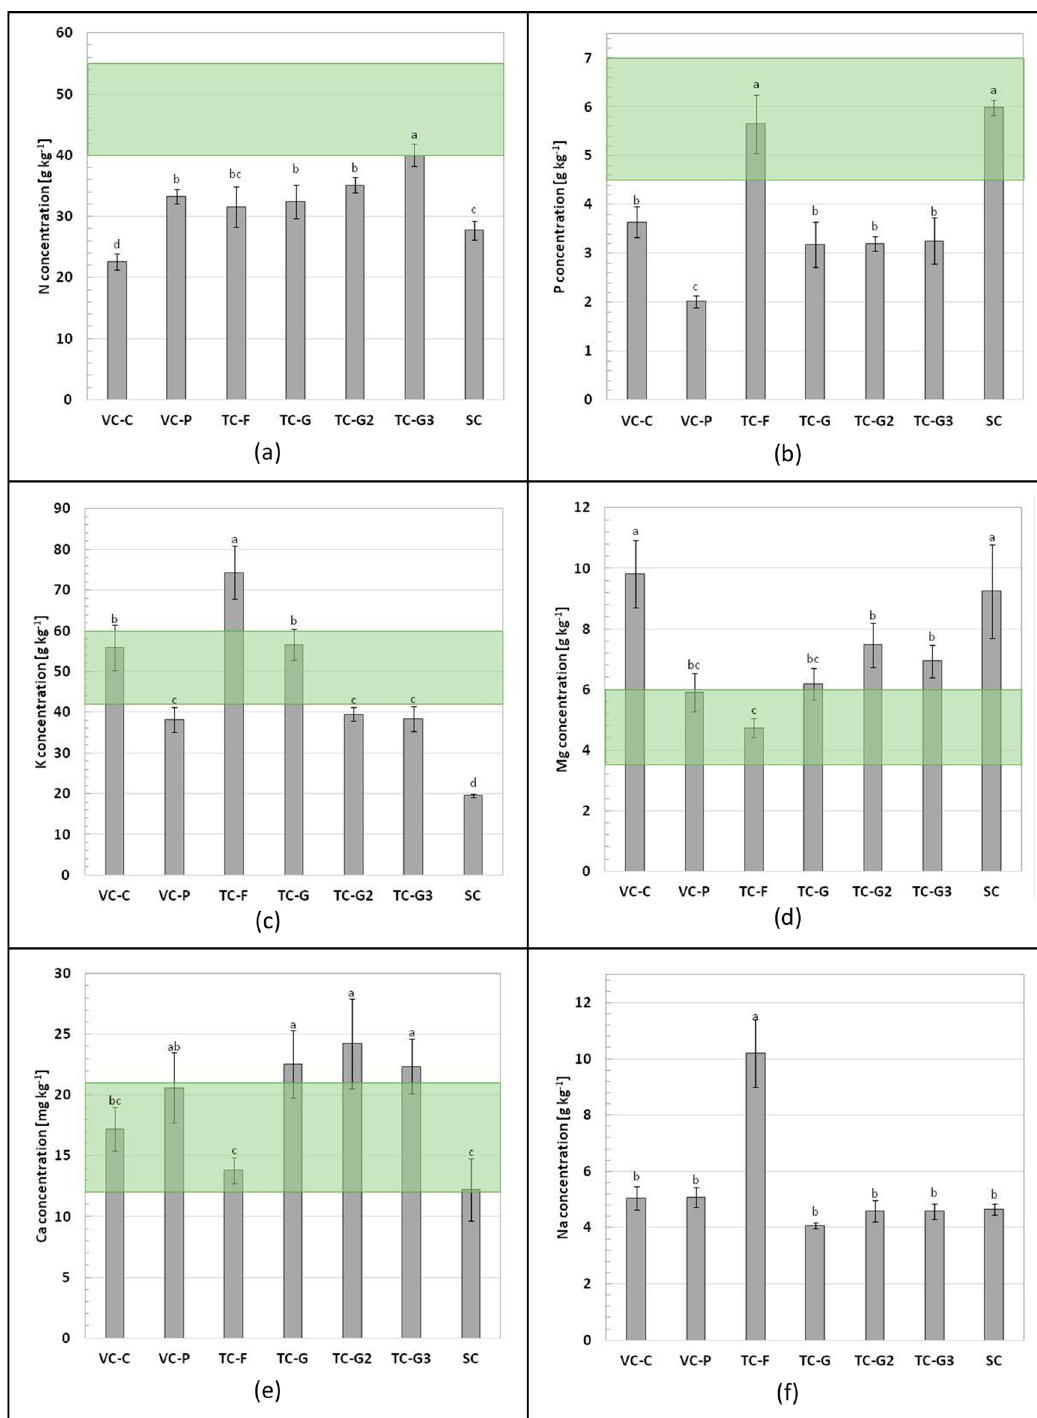
Figure 2. Contents of nutrient ( a ) N, ( b ) P, ( c ) K, ( d ) Mg, ( e ) Ca and ( f ) Na in lettuce shoots grown in all tested treatments ( n = 5). Error bars indicate standard deviation. Different letters reflect that means significantly differ from one another (HSD, Tukey test, α = 0.05; n = 5). The area highlighted in green represents the optimum range of contents, according to Bergmann [40]. SC, sand control; TC-F, thermophilic compost from fecal matter; TC-G, thermophilic compost from green waste; TC-G2 and TC-G3, thermophilic compost from green waste with additional N fertilization; VC-C, vermicompost with coir bedding material; VC-P, vermicompost with paperboard bedding material.